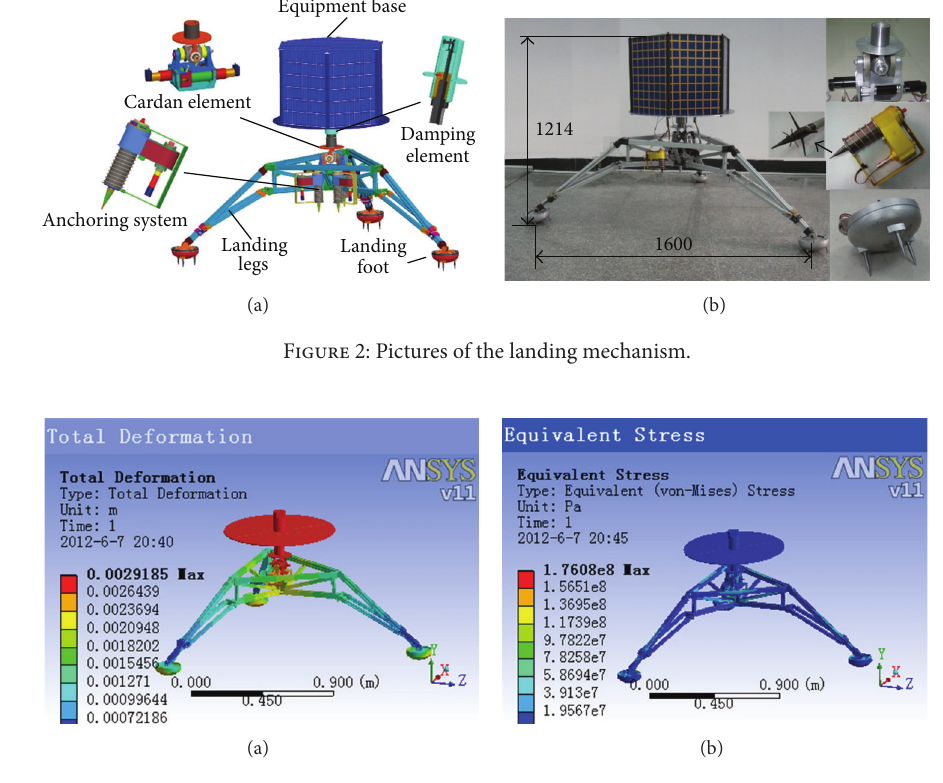
Figure 3: Static structural analysis of the landing mechanism by